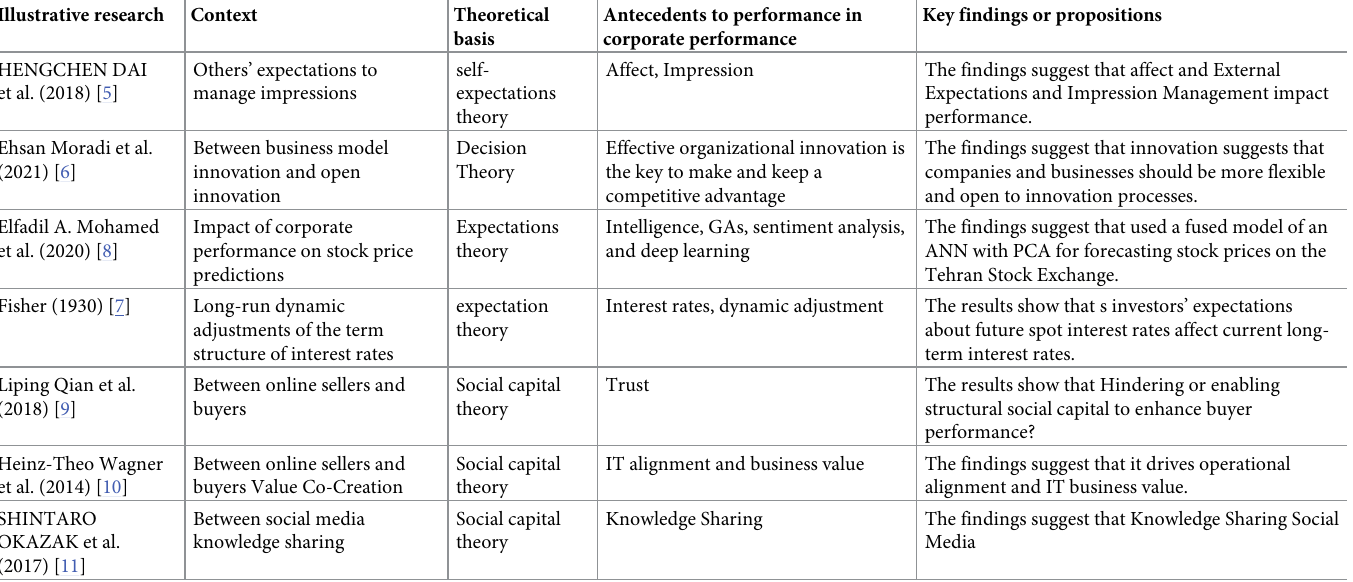
Table 1. Illustrative research summarizing the antecedents to corporate